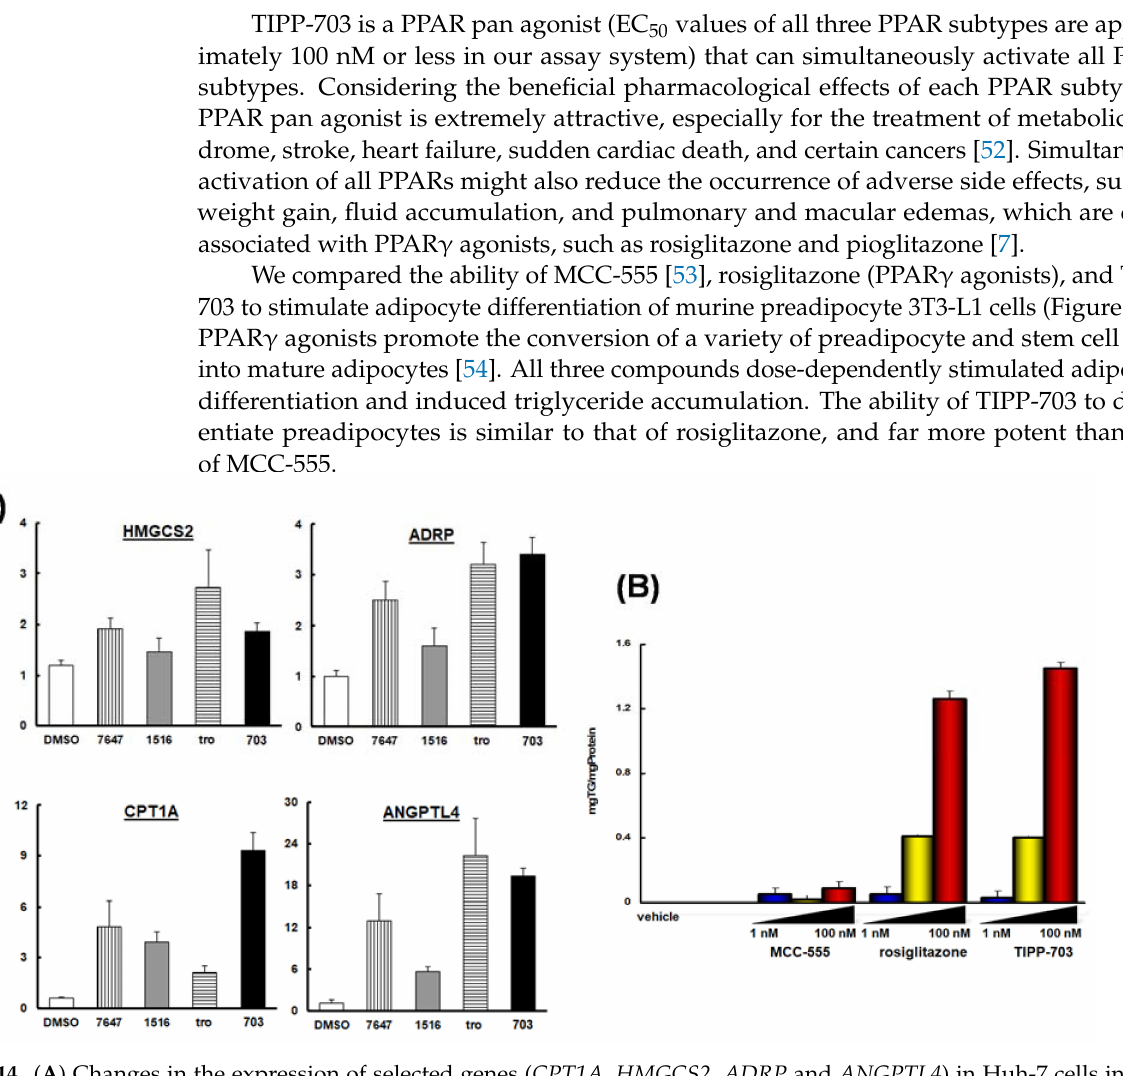
Figure 14. ( A ) Changes in the expression of selected genes ( CPT1A , HMGCS2 , ADRP and ANGPTL4 ) in Huh-7 cells in response to several PPARs agonists. ( B ) Induction of adipocyte differentiation by PPAR agonists, MCC-555, rosiglitazone, and